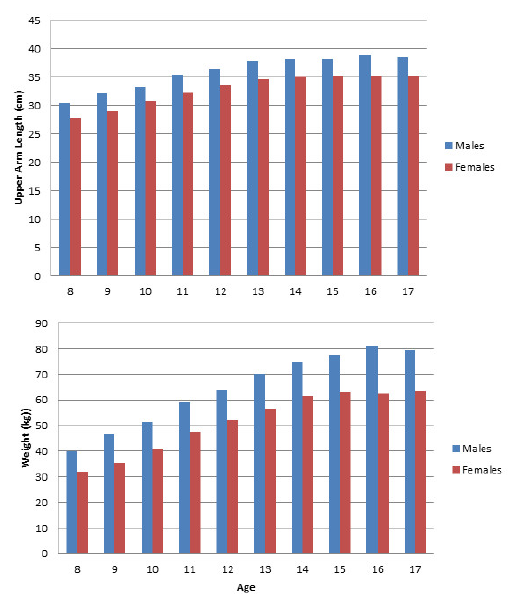
Figure 7. Graph of age differences in upper limb length for children aged 8-17 (data taken from Anthropometric Reference Data for Children and Adults : Unites States, 2007-2010; U.S. Department of Health and Human